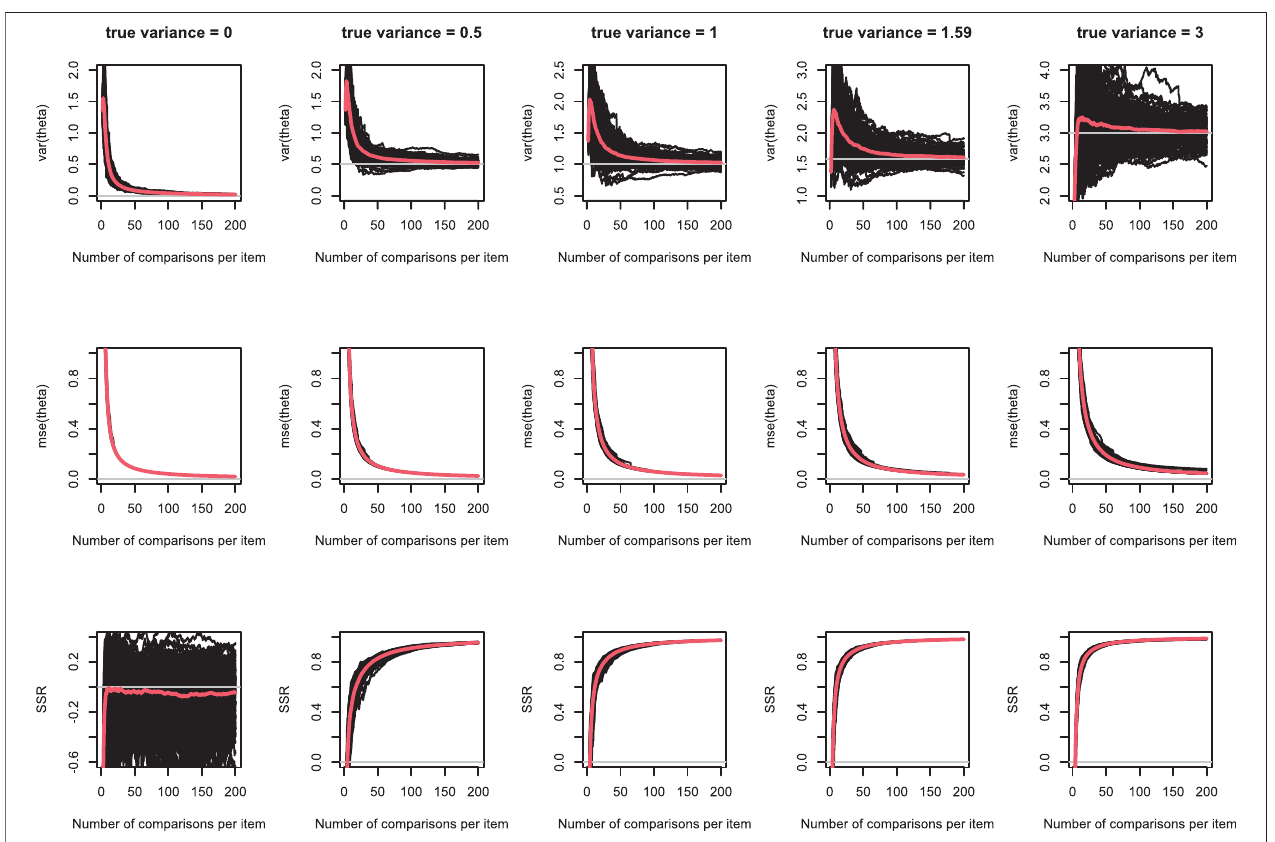
(cid:2) ) (cid:2) )] FIGURE 1 | Development of S 2 ( θ , MSE [ S ( θ , and the SSR with increasing numbers of comparisons per item of all 100 simulations (black lines) and of the average (red line) for all true variance conditions for 50 items. The x -axis shows the average number of comparisons per item for interpretation purposes, but the data points are per